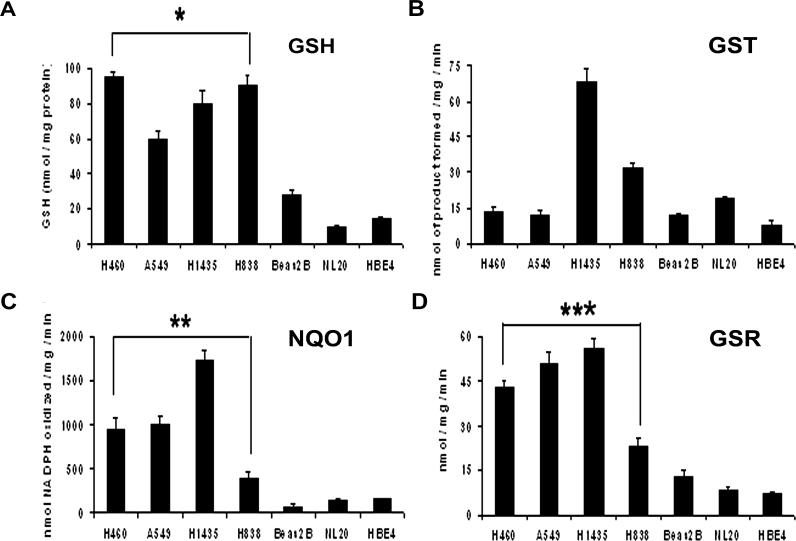
Comparison of Total GSH Levels, GST, NQO1, and GSR Enzyme Activities between Cancer Cells and Normal CellsShown are total GSH levels (A) and enzyme activities for GST (B), NQO1 (C), and GSR (D). Data represent mean ± SD (n = 3). *, p = 0.0016; **, p = 0.039; ***, p = 0.011 relative to normal cells (by t-test).